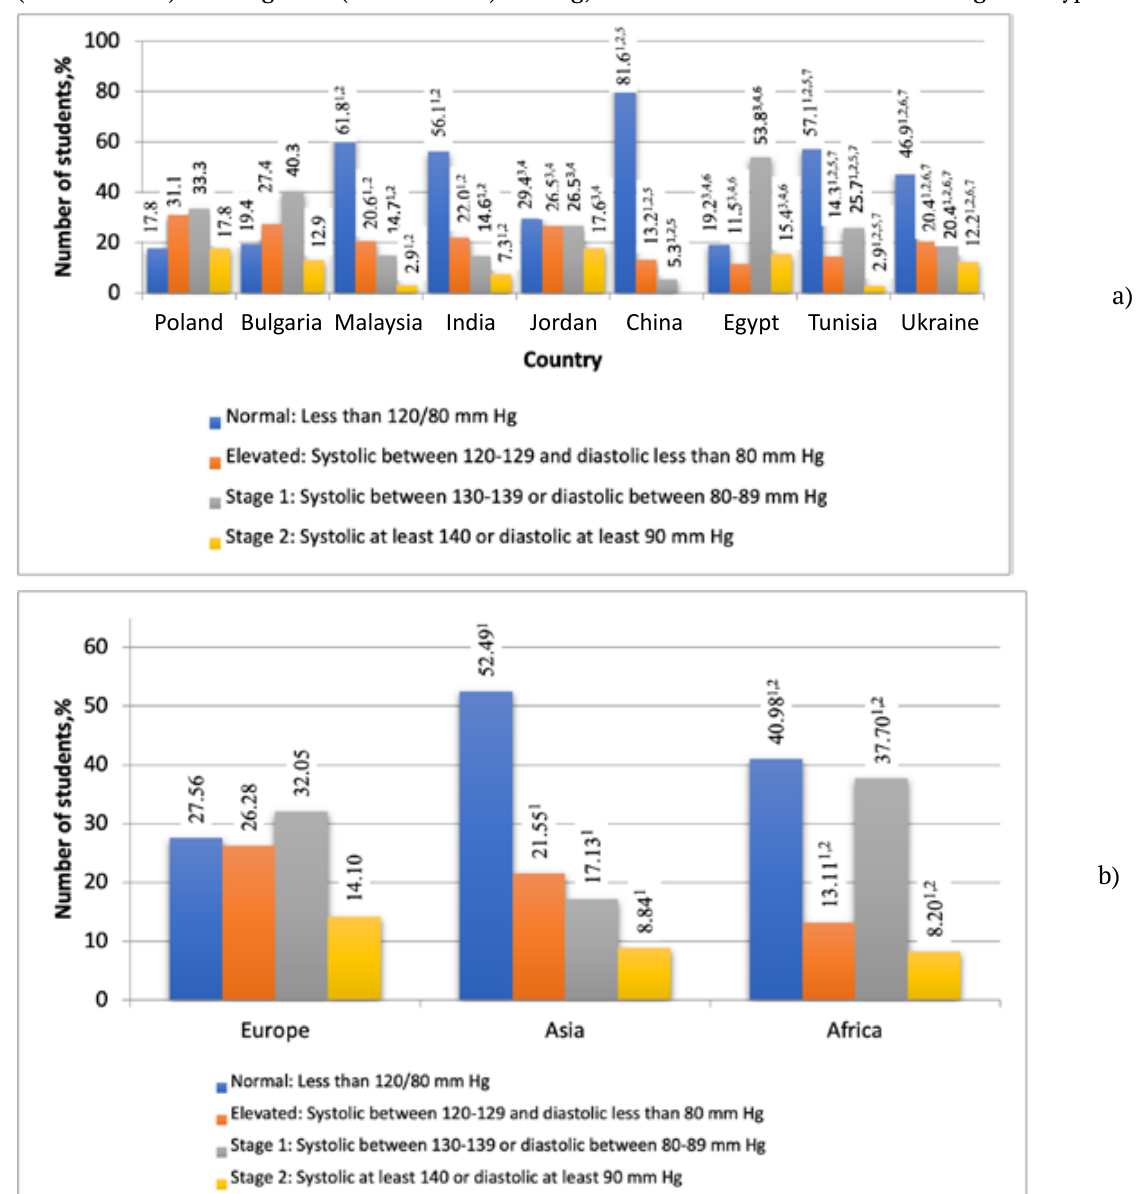
Figure 1. Frequency distribution of students by Blood pressure level (mm Hg): a) differences between representatives (shown in the form of upper index): 1 – Poland and others; 2 – Bulgaria and others; 3 – Malaysia and others; 4 – India and others; 5 – Jordan and others; 6 – China and others; 7 – Egypt and others (р < .05) (based on χ 2 -test); b) (shown in the form of a superscript): 1 – differences between representatives of the countries of Asia and Africa and Europe; 2 – differences between representatives of Asian and African countries (p < .05) (based on χ 2